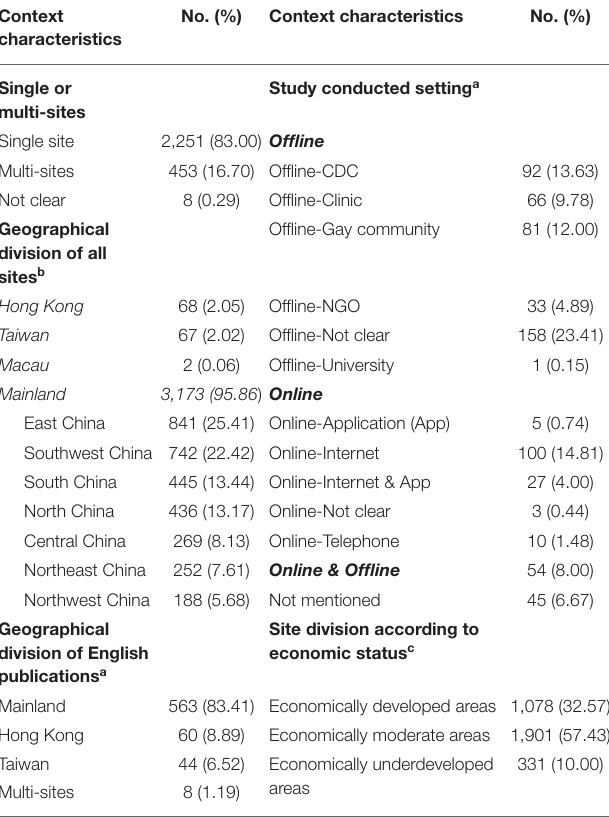
TABLE 5 | Context characteristics of all included